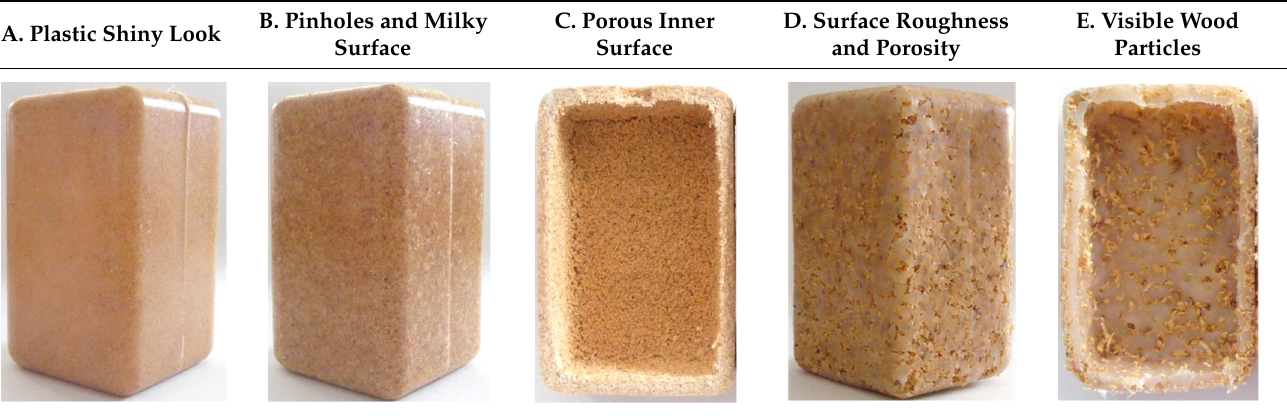
Table 4. Main defects of parts produced with MDPE/wood composites with large wood granu- lometries: (A) MDPE/10% 500–710 µm; (B) MDPE/30% 500–710 µm; (C) MDPE/30% 710–1000 µm;